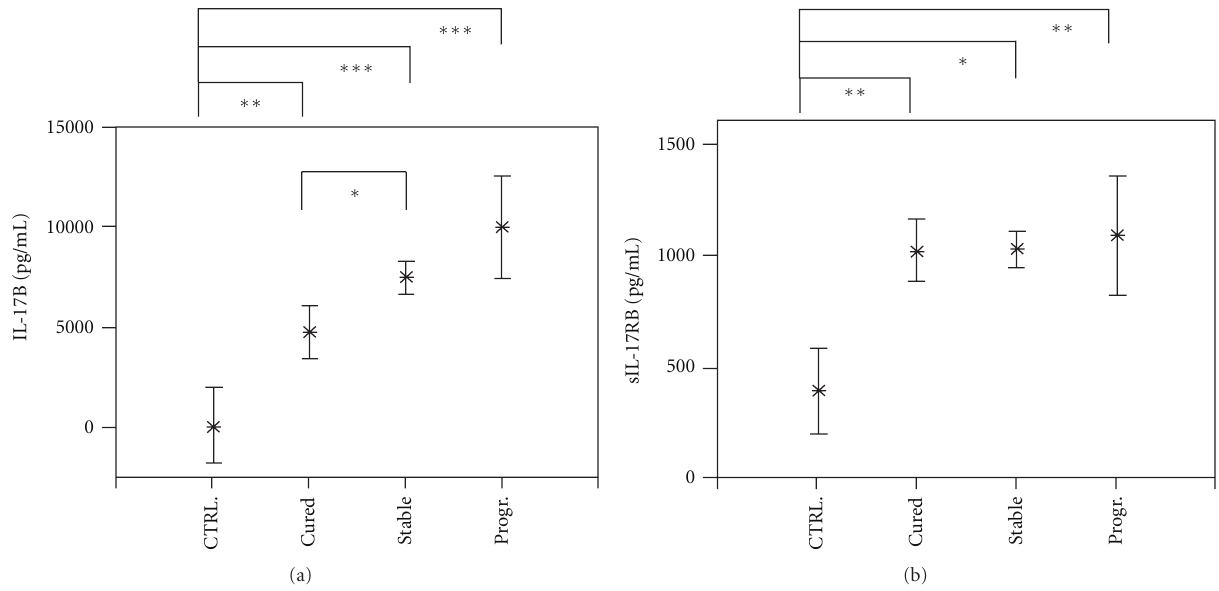
Figure 1: Plasma concentrations of interleukin (IL)-17B (part a) and soluble receptor IL-17RB (part b) in Alveolar Echinococcosis (AE) patients and in infection-free controls (CTRL). The patients were grouped according to their state of infection, that is, cured, stable, or progressive (Prog.) Alveolar Echinococcosis. The plasma concentrations are shown as the mean values in pg/mL with the 95% upper and lower confidence interval. The level of significance was adjusted by the Bonferroni-Holm method. Significant di ff erences between the groups are indicated ( ∗ P < 0 . 05, ∗∗ P < 0 . 01, and ∗∗∗ P < 0 . 001).